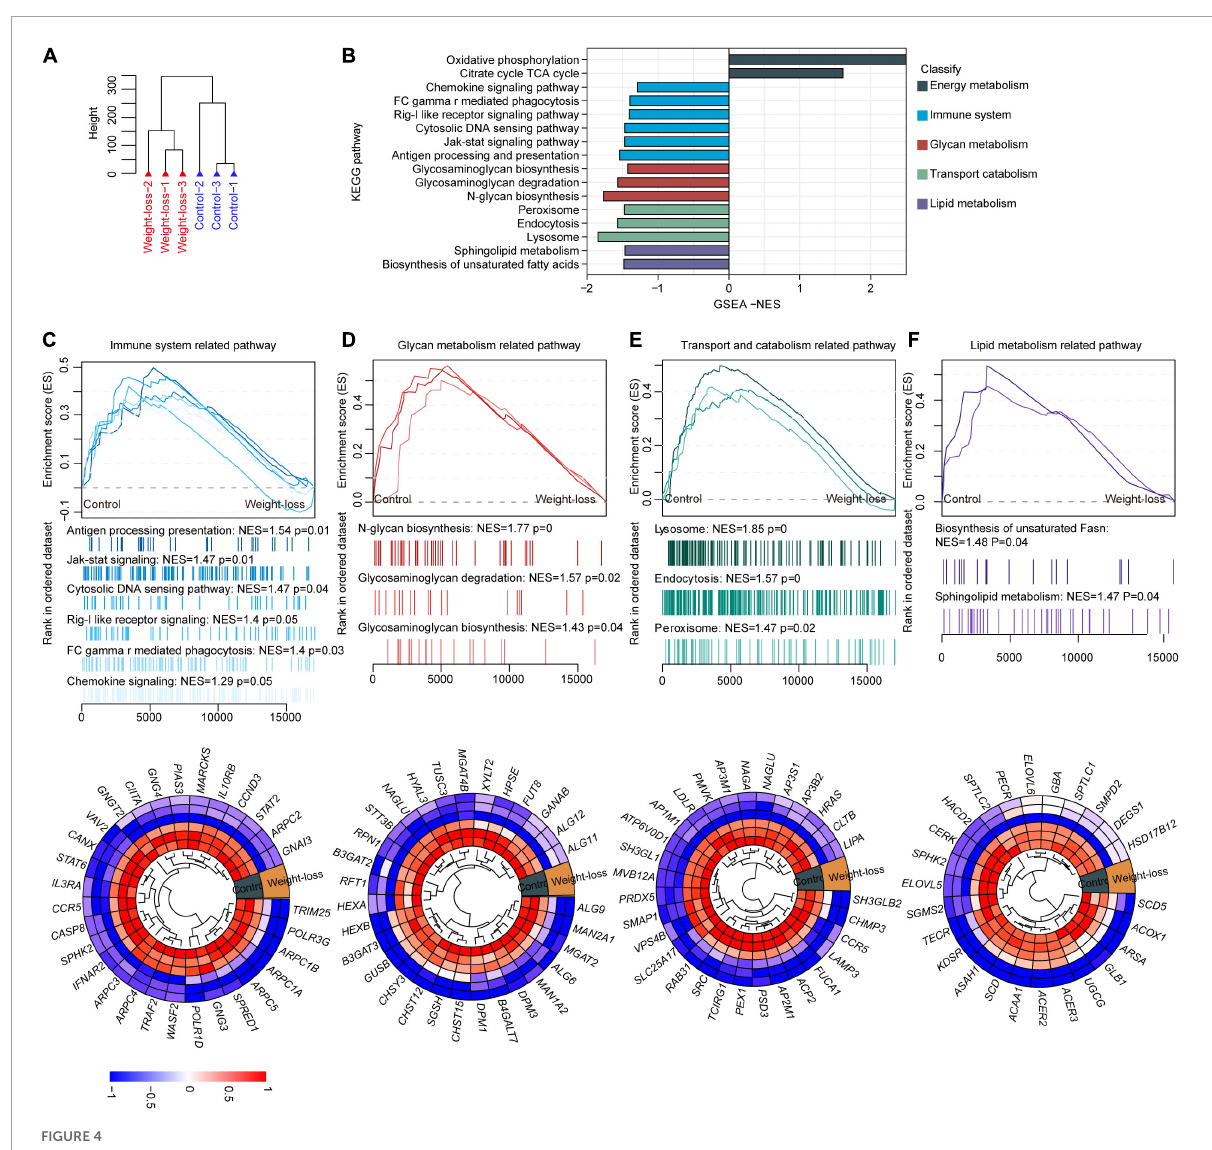
FIGURE4 The metabolic signature of subcutaneous adipose tissue in a weight-loss diet in beagles. (A) Total RNA was extracted from subcutaneous adipose tissues of control diet and weight-loss diet beagles after 8 weeks of feeding followed by RNA-seq analysis. PCA Cluster showed the distribution of samples from beagles fed a weight-loss diet control diet according to gene expression patterns in RNA-seq. n = 3 beagles/group. (B) Gene set enrichment analysis (GSEA) was carried out between the control diet and weight-loss diet beagles. GSEA showing the enriched pathways related to lipid metabolism based on the RNA-seq dataset in control diet and weight-loss diet beagles after 8 weeks of feeding. (C) Representative GSEA enrichment score curves of immune system-related pathways. Genes on the far left correlated the most with control diet samples, and genes on the far right correlated the most with weight-loss diet samples. A representative heatmap of the leading genes is shown below the curve. (D) Representative GSEA enrichment score curves and heatmap of the glycan metabolism-related pathways and corresponding leading genes. (E) Representative GSEA enrichment score curves and heatmap of the transport catabolism-related pathways and corresponding leading genes. (F) Representative GSEA enrichment score curves and heatmap of the lipid metabolism-related pathways and corresponding leading